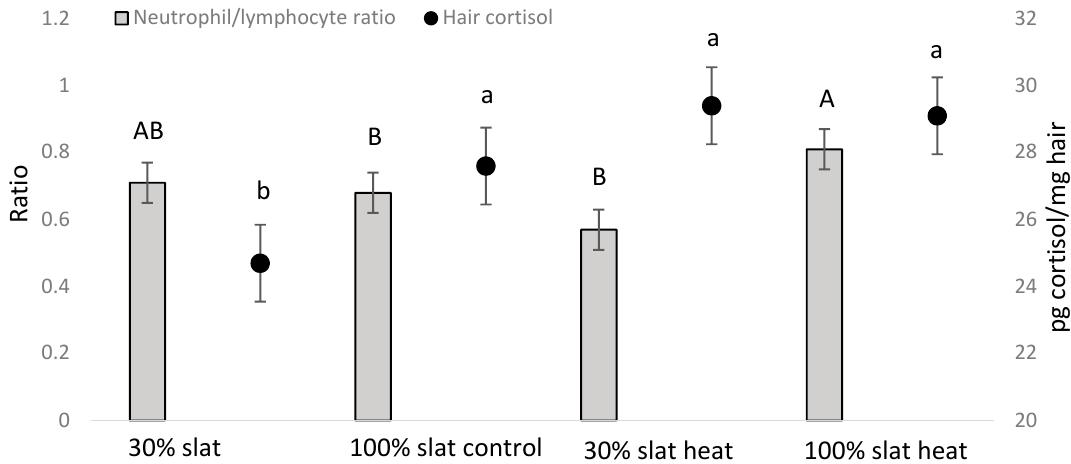
Figure 6. Mean ± SE of neutrophil / lymphocyte ratio (in bars) and hair cortisol (points) in pigs at the end of the study depending of the environmental temperature (control vs. heat) and type of floor (30% slat 70% concrete vs. 100% slat). Di ff erent letters mean significant di ff erences at p <